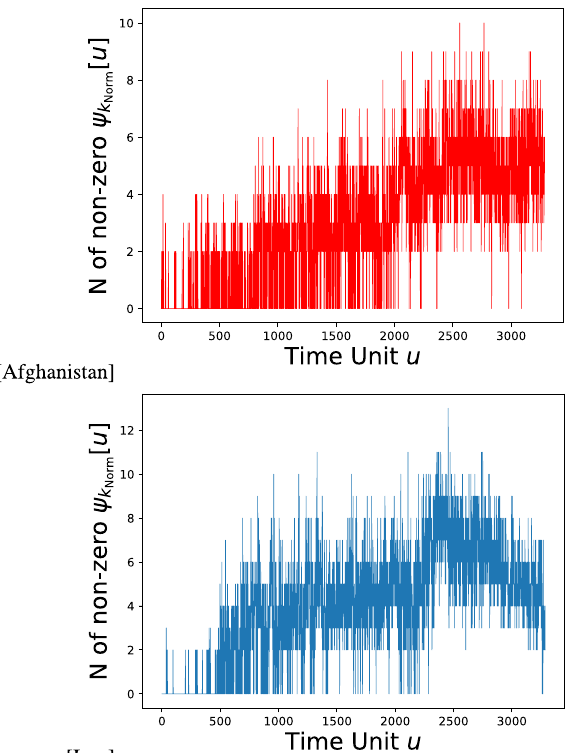
Figure 6. Temporal Trend of the count of non-zero centrality values ψ k Norm [ u ] in the target dimension for Afghanistan and Iraq. The figures have been created using Matplotlib version 3.1.3. https:// matpl otlib. org/3. 1.3/ conte nts.